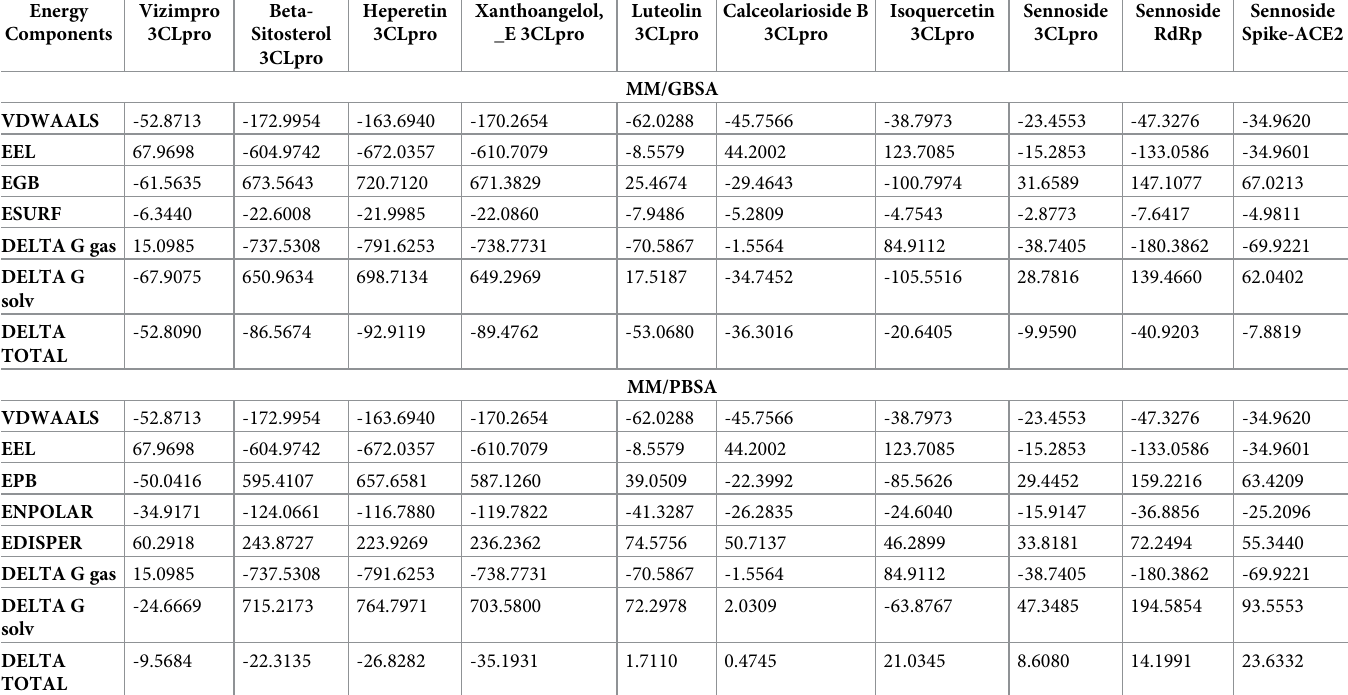
Table 3. Binding free energy and its components in MM/GBSA and MM/PBSA for the active phytochemicals, Senna compounds, and vizimpro in complex with 3CL pro , RdRp, and spike-ACE2 proteins in kcal/mol. Energy